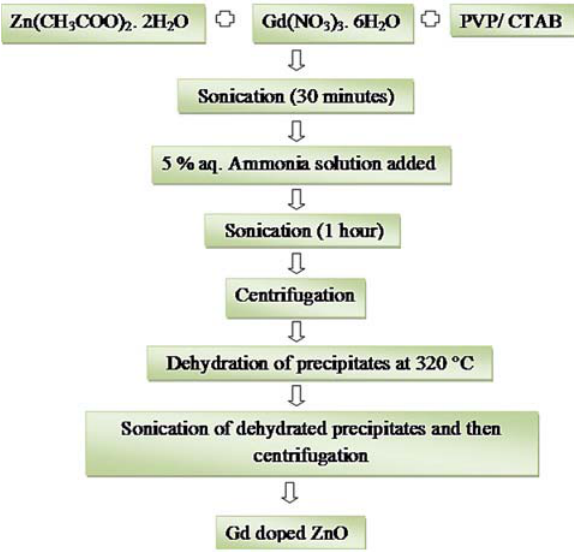
Figure 1. Flowchart of synthetic procedure of Gd doped